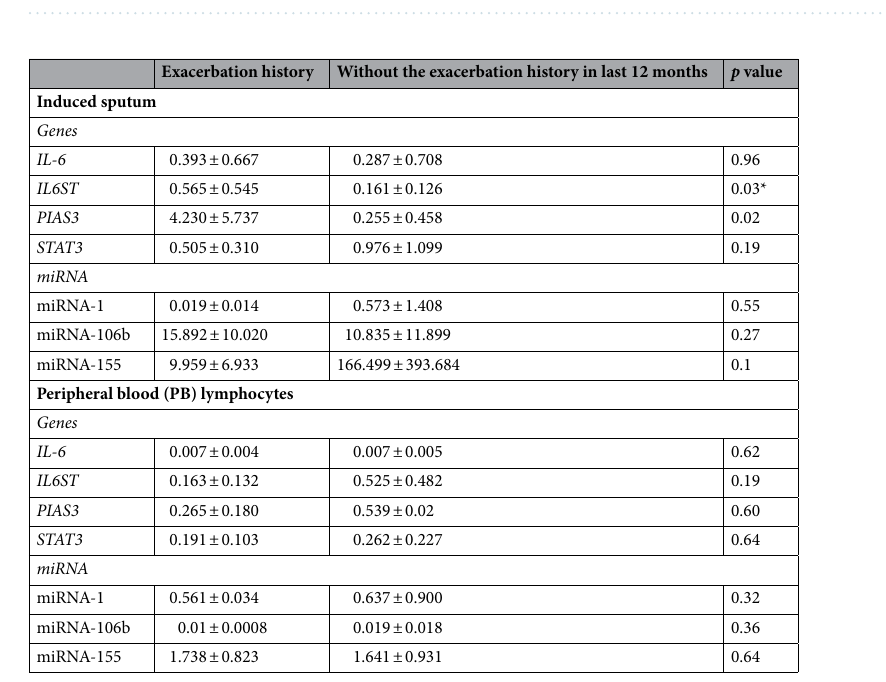
Figure 4. Box-and-whisker plots representing the expression value (median RQ value) of ( a ) IL6ST ( p = 0.03) ( b ) PIAS3 ( p = 0.02) in COPD patients according to the exacerbation history in induced sputum.